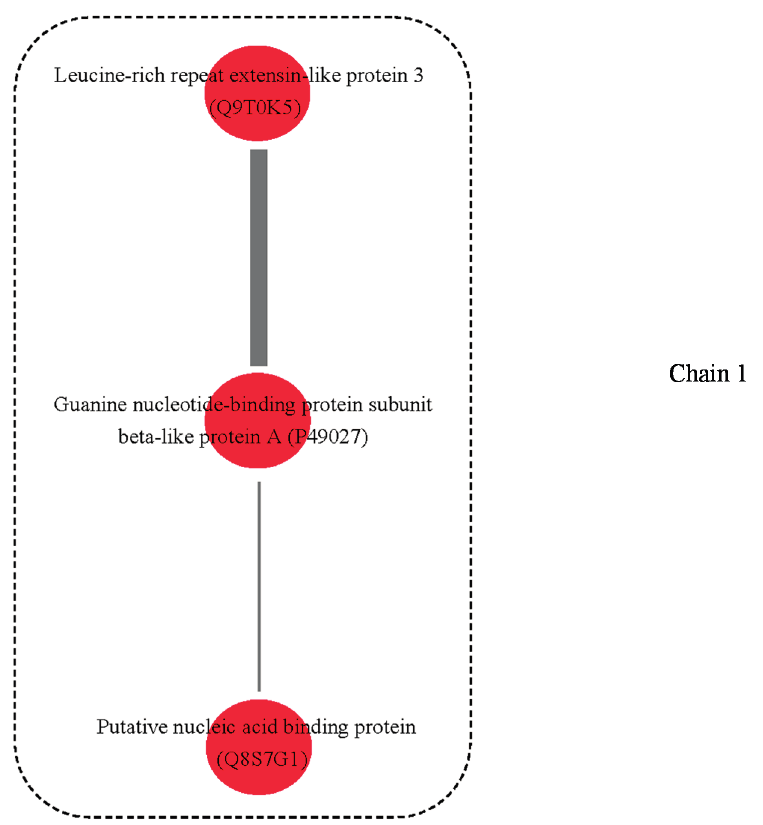
Figure 3. Possible protein-protein interaction chain among 9 annotated proteins derived using the Cytoprophet module of Cytoscape. Cytoprophet draws a chain of potential interactions with probability scores and GO distances as edge attributes. UniProt ID names in